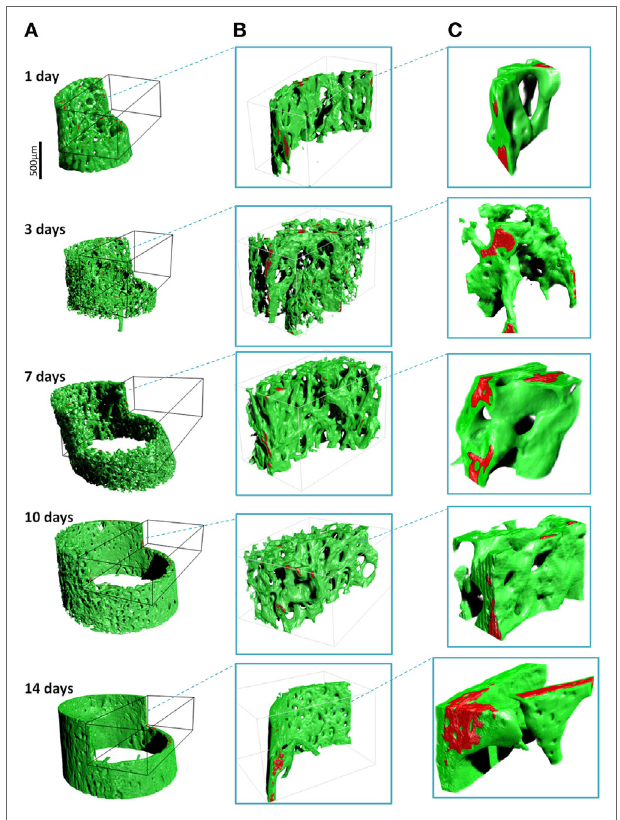
FigUre 6 | 3D renderings of the bone (green) and high-density zones (red) with increasing magnifications ( (a) , (B) and (c) ). The high mass density (exceeding 1.9 g/cm 3 ) is always found within regions of lower density. Note the drastic architectural changes from 1 to 14 days, changing from a foamy network to a solid cortical